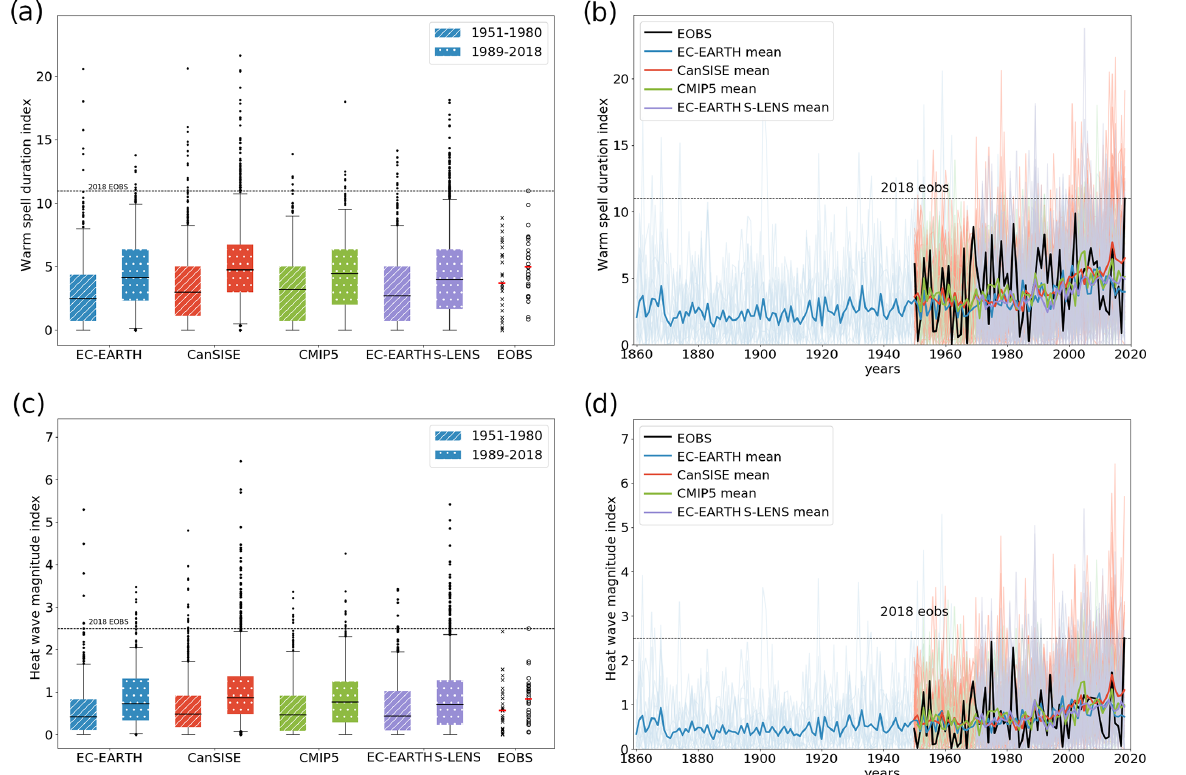
Figure 5. As Fig. 4 but for (a, b) WSDI and (c, d)